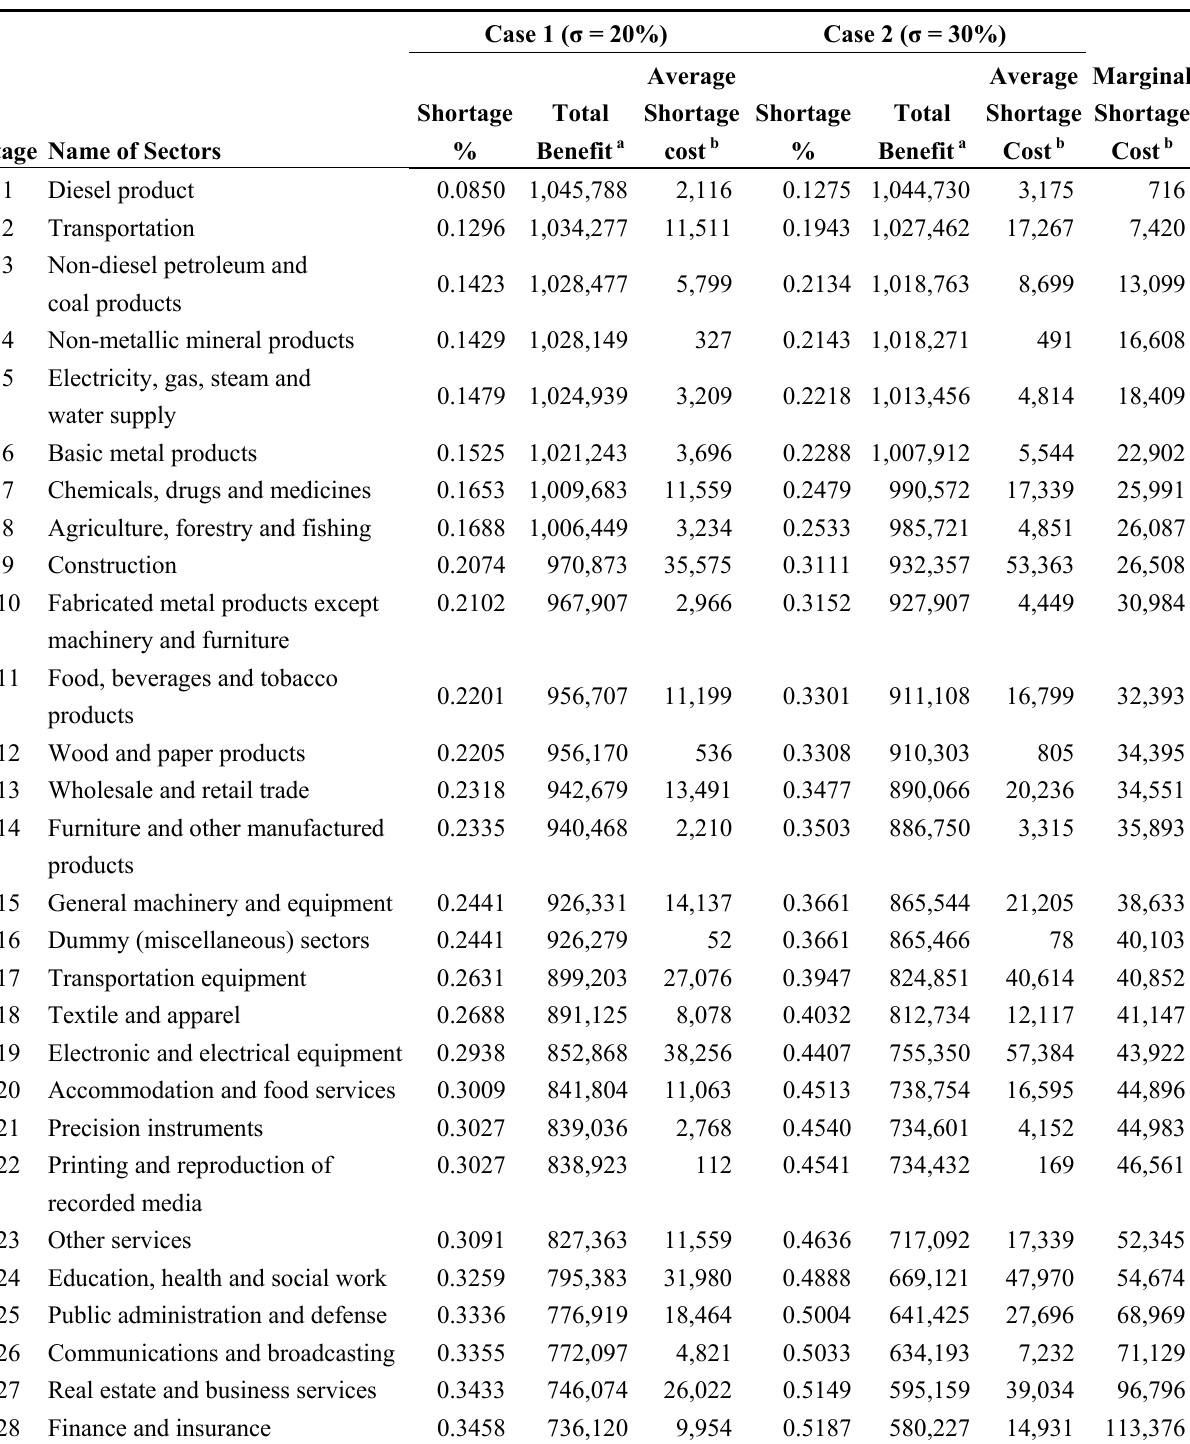
Table 3. Average and marginal shortage costs of unsupplied